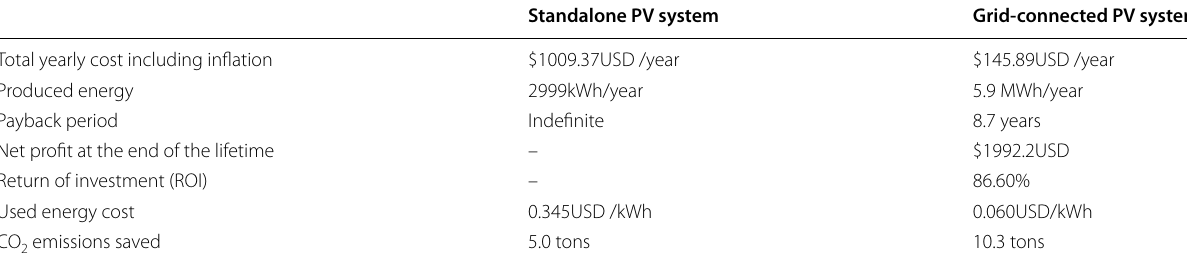
Table 9 Comparison between of a stand-alone and grid-connected proposed PV system